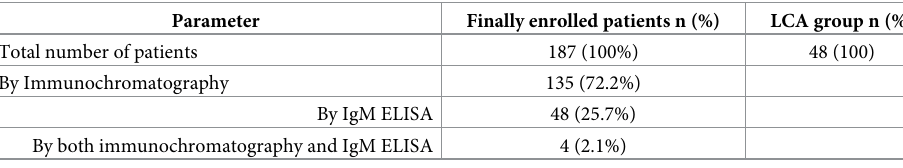
Table 1. Diagnostic outcomes of